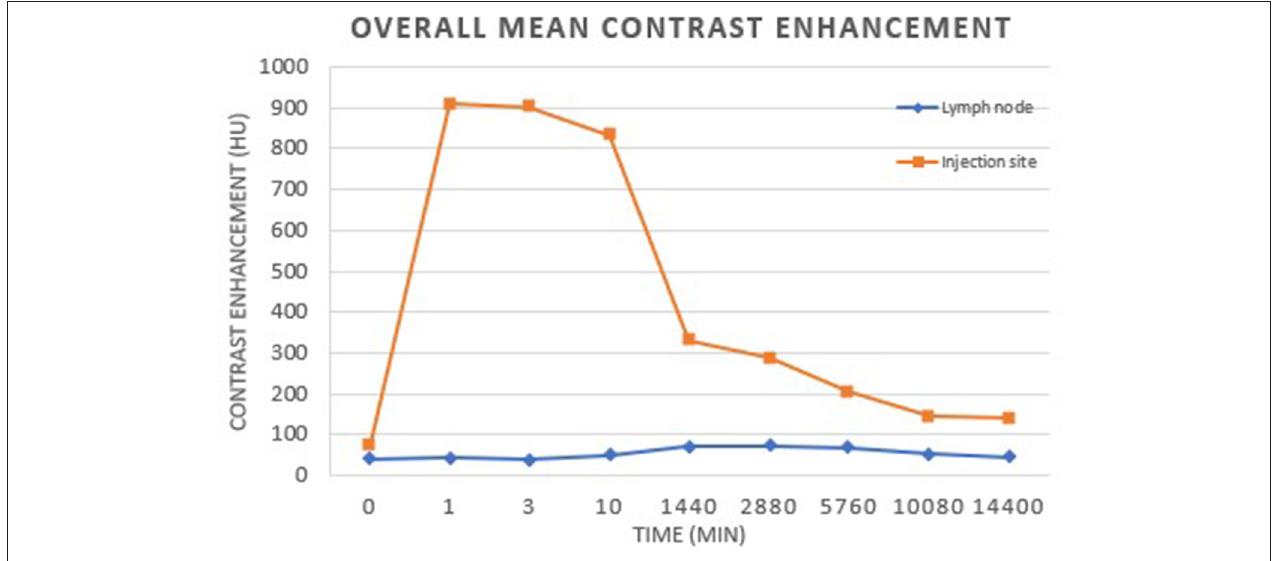
FIGURE 3 | Overall mean contrast enhancement of the injection site and lymph nodes. The peak mean contrast enhancement of the lymph nodes was 73.98 HU at 2 days post-injection. There was a significant difference in SLN contrast enhancement at each time point compared to baseline ( p < 0.01). The peak mean contrast enhancement at the injection site was 910.86 HU at 1min post-injection. There was a significant difference in contrast enhancement at the injection site at each time point compared to baseline ( p < 0.001).